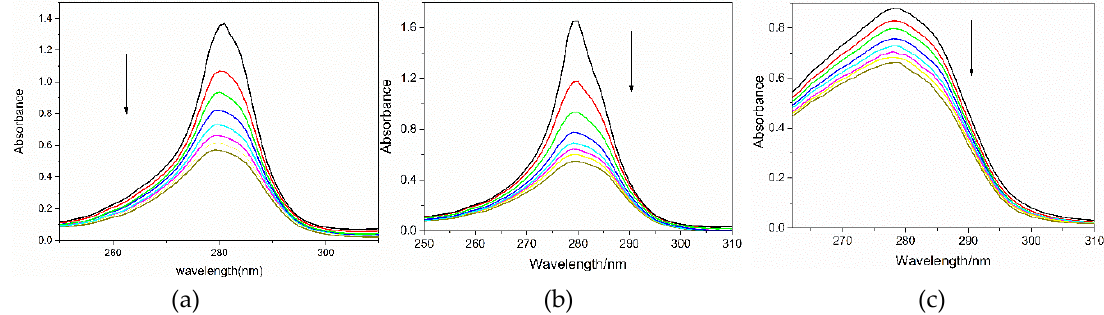
Figure 5. The absorption spectra of BSA under different concentrations of ( a ) BR2, ( b ) VBB and ( c ) FB. The arrows indicate the BSA spectra change with the addition of the dye molecules at different concentrations for 0 ( — ), 4( — ), 8( — ), 12( — ), 16( — ), 20( — ), 24( — ), and 28( — ) µ M. ( n = 3).